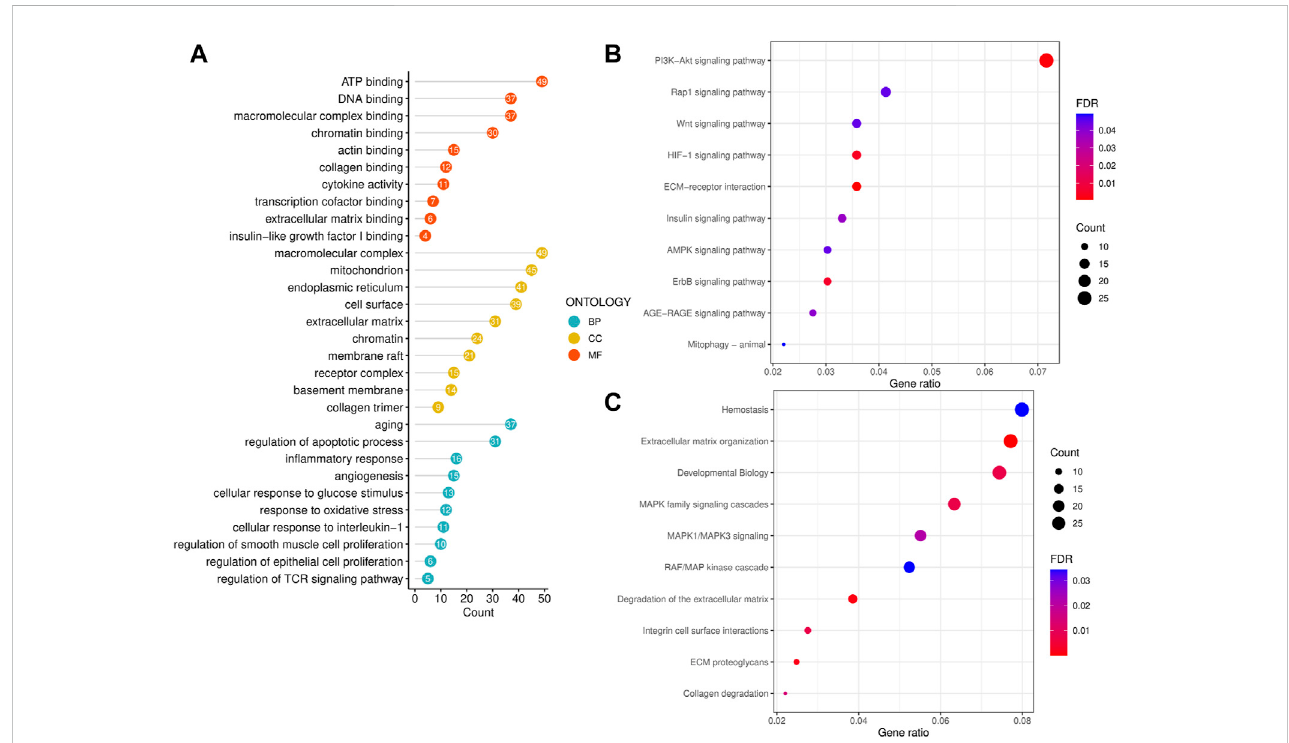
FIGURE 3 Functional enrichment analysis of signi fi cant CPRGs. (A) GO enrichment analysis of signi fi cant CPRGs. (B) KEGG enrichment analysis of signi fi cant CPRGs. (C) Reactomeenrichmentanalysisofsigni fi cantCPRGs.CP,chronicprostatitis;CPPS,chronicpelvicpainsyndrome;CPRGs,CP/CPPS-relatedgenes; GO, Gene Ontology; BP, biological process; CC, cellular component; MF, molecular function; KEGG, Kyoto Encyclopedia of Genes and Genomes; FDR, false discovery